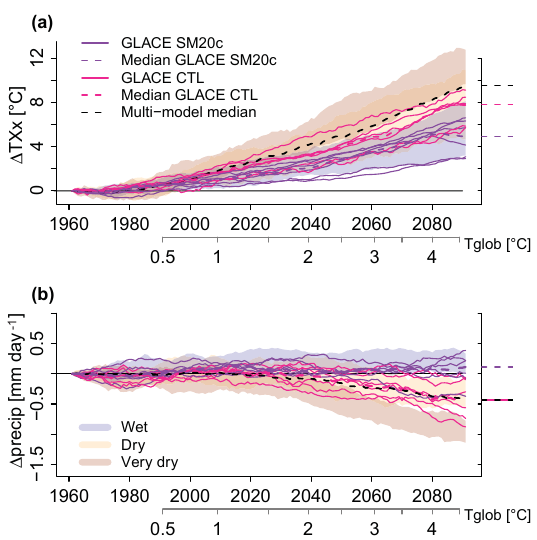
Figure 3. Change in (a) TXx and (b) summer precipitation (pre- cip) in CEU with respect to the base period (1951–1970). Changes are computed based on 20-year moving averages with respect to the base period. The shaded area shows the minimum and maxi- mum from the wet (blue), dry (orange) and very dry (red) models. Changes for GLACE CTL (pink) and GLACE SM20c (violet) are also shown. Dashed lines represent the multi-model median of the full ensemble (black) and GLACE CTL (pink).